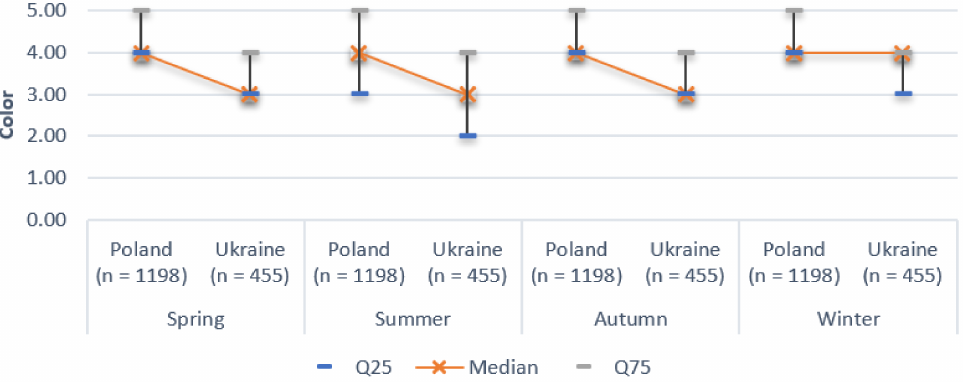
Figure 5. Assessment of tap water color during individual periods of the year by groups of respon- dents from Poland and Ukraine.